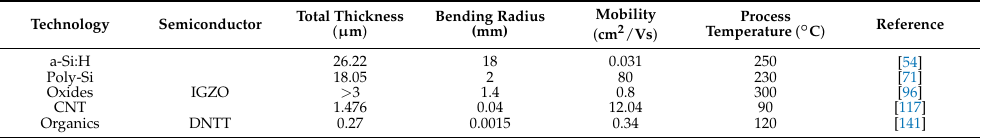
Figure 14. The comparison of bending radius over a-Si:H, poly-Si, oxides, CNTs, and organic semiconducting technologies. Table 6. Comparison of semiconducting